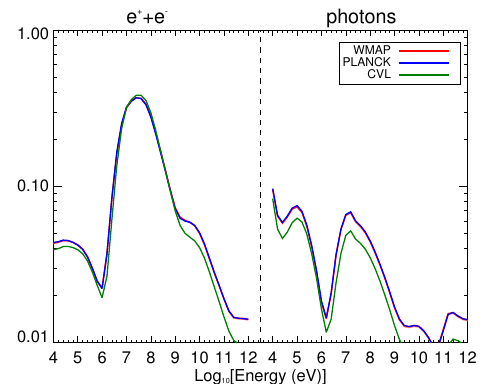
Figure 3: f coefficients as a function of energy for e + e − ( left panel ) and photons eff ( right panel ), for decaying DM with a lifetime much longer than the age of the uni- verse. Figure reproduced from Ref. [ 58 ]